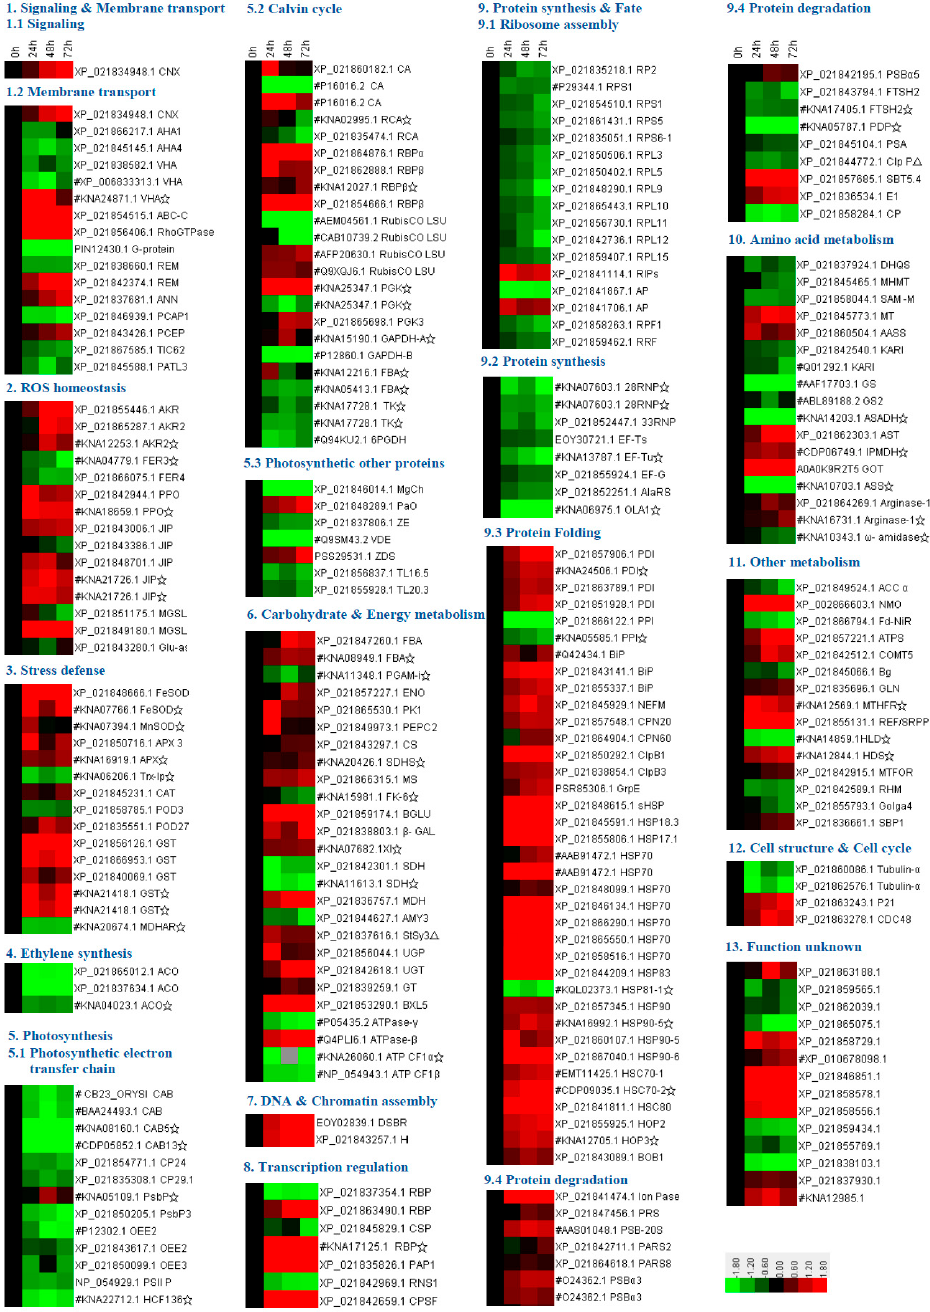
Figure 6. Abundance patterns of heat-responsive proteins in leaves of spinach Sp73 revealed from proteomic analysis. The four columns represent different heat treatments at 37 °C/32 °C (day/night) for 0 h, 24 h, 48 h, and 72 h. The rows represent individual proteins. The increased or decreased proteins are indicated in red or green, respectively. The color intensity increases with increasing abundance differences, as shown in the scale bar. The scale bar indicates the log (base2)-transformed relative protein abundance ratios ranging from − 1.8 to 1.8. Database accession numbers and the abbreviations of protein names are listed on the right side (please refer to Supplementary Table S3 for the full protein names). The database accession numbers are from NCBInr. Those marked with the pound signs (#) indicate the proteins identified by the 2DE-based proteomics approach, and the rest were identified by the iTRAQ-based proteomics approach. The protein names marked with pentagrams ( ☆ ) were annotated according to the functional domain annotation from the NCBInr protein database.